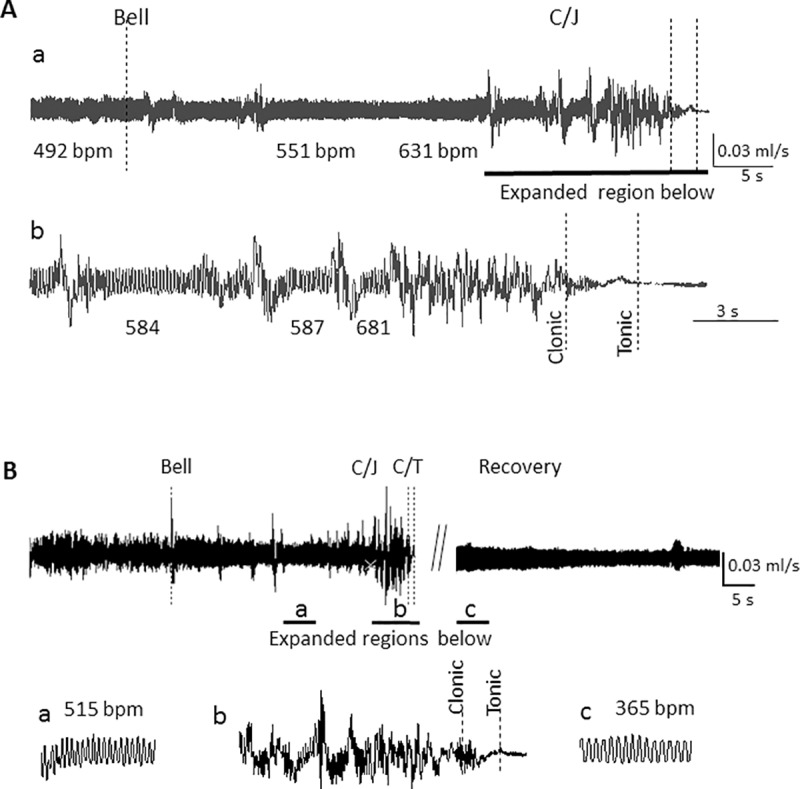
Respiratory arrest occurs during the clonic phase, but before the start of the tonic phase.A: Plethysmography recording of respiration is shown during a C/T seizure in the DBA/1 mouse. a. Mouse responds to an acoustic stimulation (Bell) with 2 cycles of circling and jumping (C/J) and a single cycle of circling before entering a clonic/tonic (C/T) seizure. As denoted by the breaths per minute (bpm) calculated from random 10 sec samples within the range above the number, respiration frequency varied before the bell, depending on the ongoing activity of the mouse (consistent with exploring, sniffing and grooming). b. As shown in the expanded trace, respiration is maintained between cycles of circling/jumping, but is reduced entering the clonic phase and has ceased before entering the tonic phase. Dashed lines in all figures indicate the beginning of the phase indicated by the label. This mouse was not resuscitated. Air flow is expressed as ml/sec in this and subsequent figures. B: Respiration recovers following resuscitation by mechanical ventilation. Mouse responds to the stimulus with a single period of circling/jumping followed quickly by the C/T phases. The chamber was opened (at // marks) and room air applied through tubing placed loosely over the nose. This mouse responded within 8 sec with a series of visualized gasps that evolved to normal inspiration. When confident the mouse was breathing independently, the chamber was closed and the recording continued. As seen in the expanded traces (a, b, c), respiration again ceased by the end of the clonic phase. Following resuscitation (c) the animal was breathing independently, but was not physically recovered and remained still with little movement in the chamber. Traces a and c are 2.5 sec in length; b is 8 s.